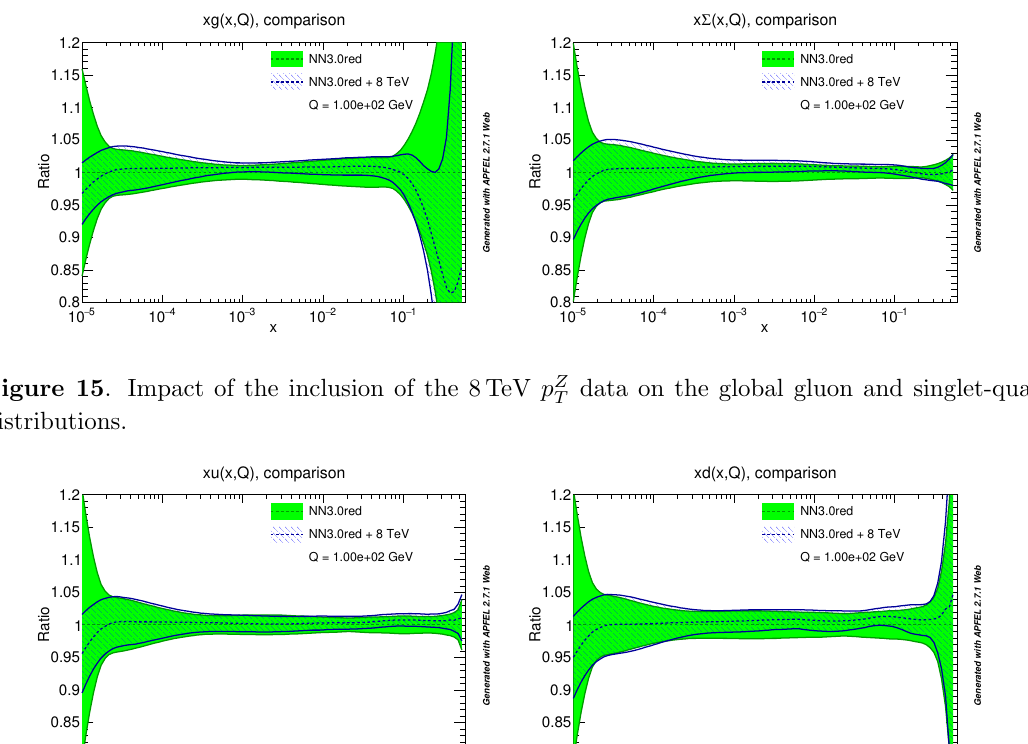
Figure 16 . Impact of the inclusion of the 8 TeV p Z